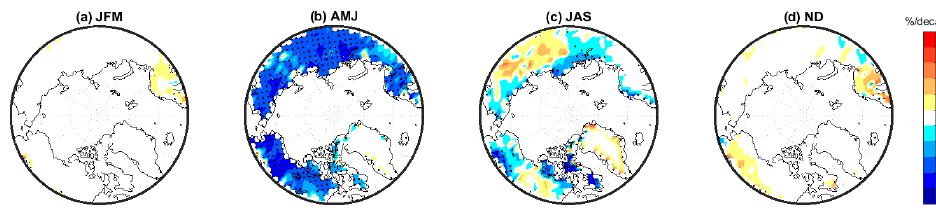
Figure 3 . Linear trends in SCE (percent per decade) by season over the 1972–2021 period calculated from weekly NOAA snow charts [38] . Trends were computed by linear regression and trend significance (black dots) assessed with a two-tail t-test ( p < 0.05).